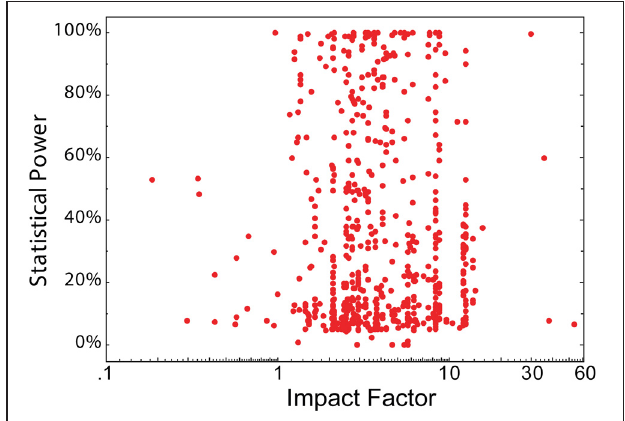
FIGURE 2 | No association between statistical power and journal IF. The statistical power of 650 neuroscience studies (data from Button et al., 2013; 19 missing ref; 3 unclear reporting; 57 published in journal without 2011 IF; 1 book) plotted as a function of the 2011 IF of the publishing journal. The studies were selected from the 730 contributing to the meta-analyses included in Button et al. (2013), Table 1 , and included where journal title and IF (2011 © Thomson Reuters Journal Citation Reports) were